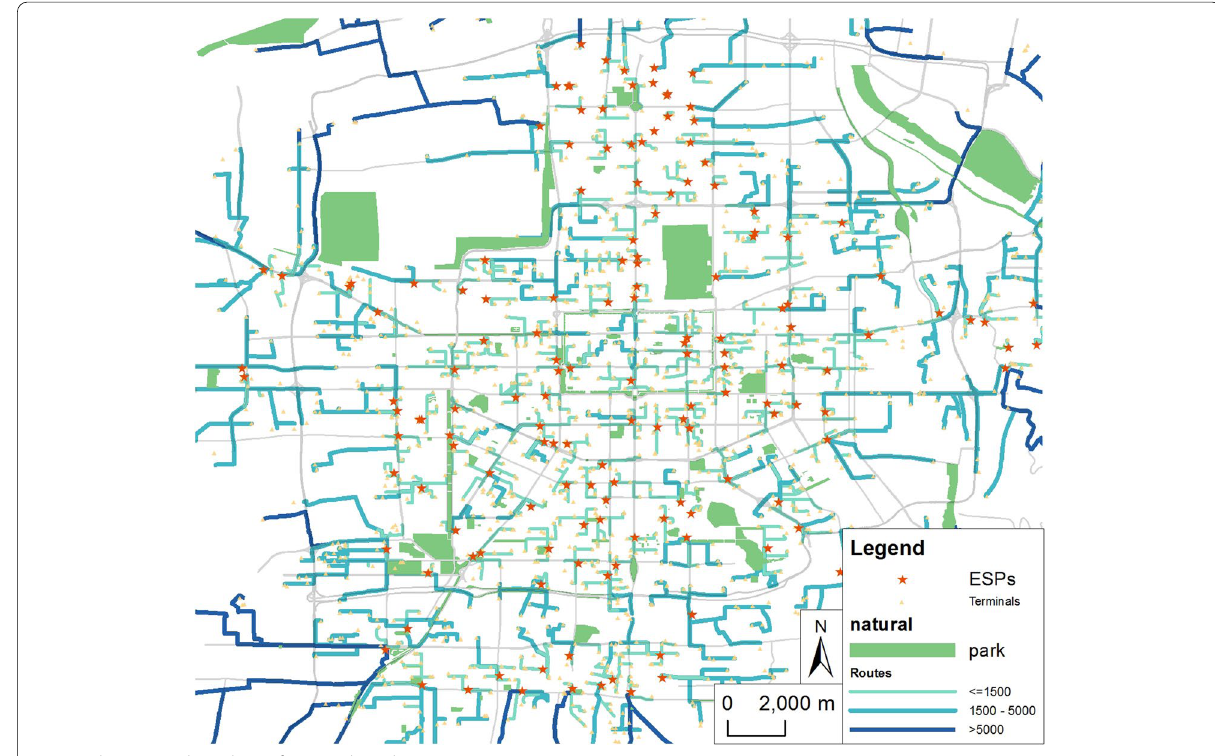
Fig. 7 Shortest path analysis of terminals and